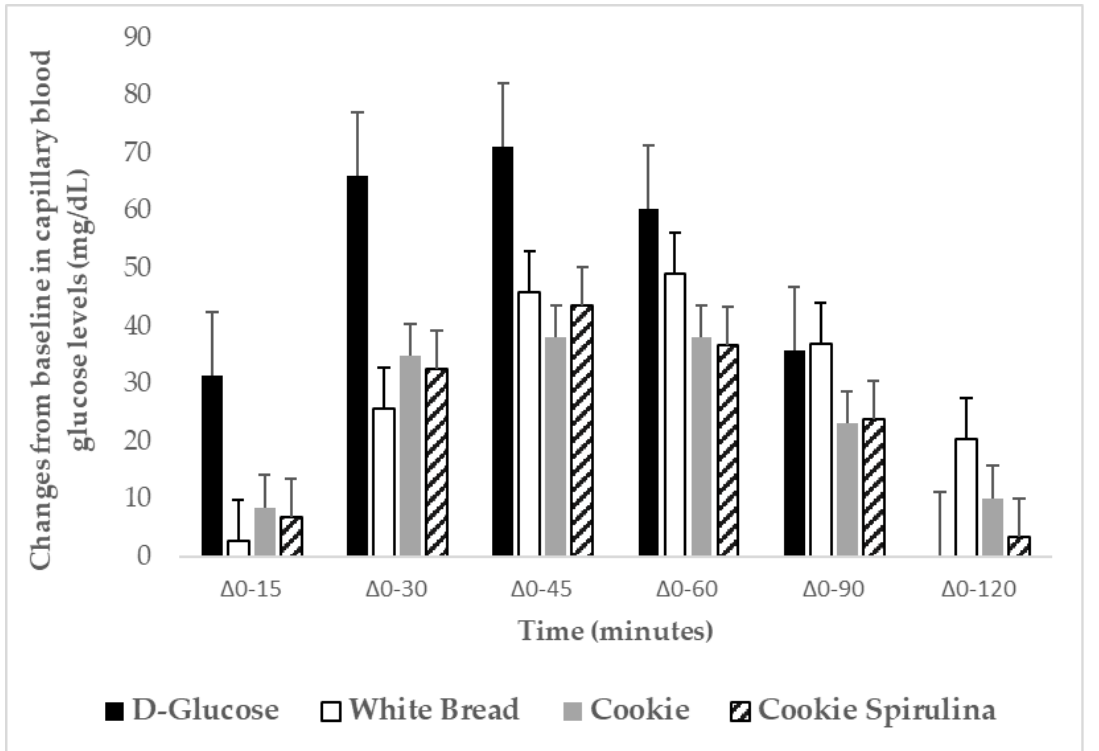
Figure 2. Changes from baseline ( Δ ) for capillary blood glucose concentrations (mg/dL) after the consumption of the test foods: plain cookies containing 50 g available carbohydrates, cookies containing 50 g available carbohydrates (2.5 g spirulina), white bread, and the reference food (D- glucose) ( n = 13). Data are means ± SEM. Data were compared by post hoc analysis of repeated measures ANOVA. The models included the factors “subject” (id), “sequence” for inter-subject variation, and “period” and “treatments” to account for intra-subject variability.